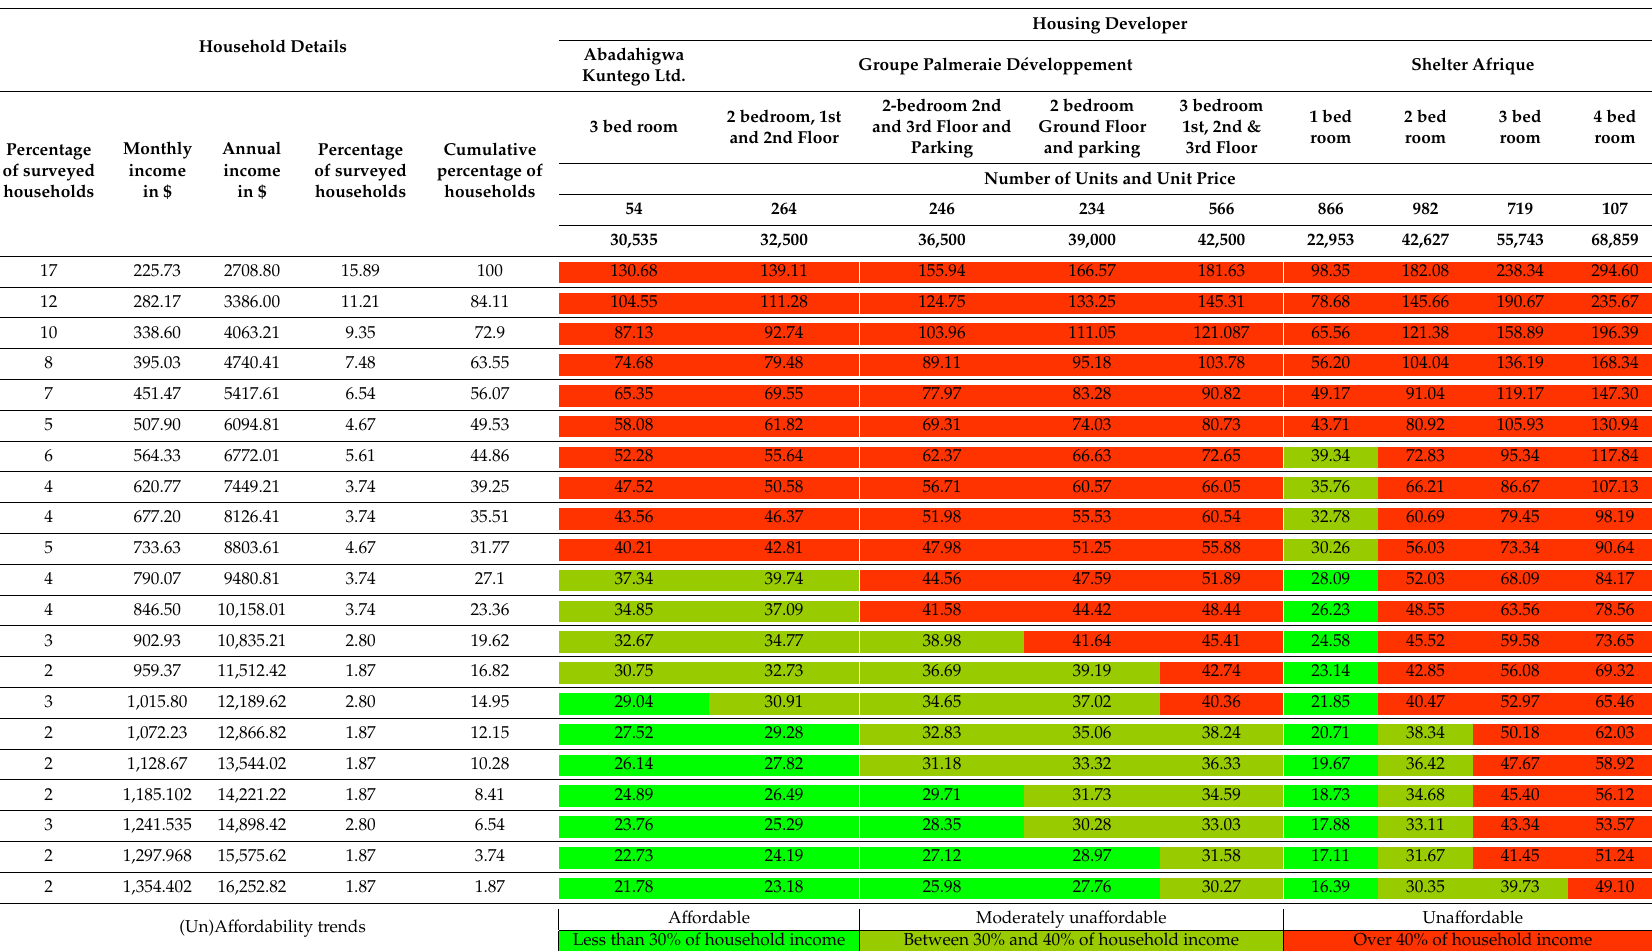
Table 6. Housing a ff ordability indices based on bank loan at 30% of the household’s monthly income. Data source: Field survey (July to September 2018 and from January to March 2019) and review of housing price lists held by real estate